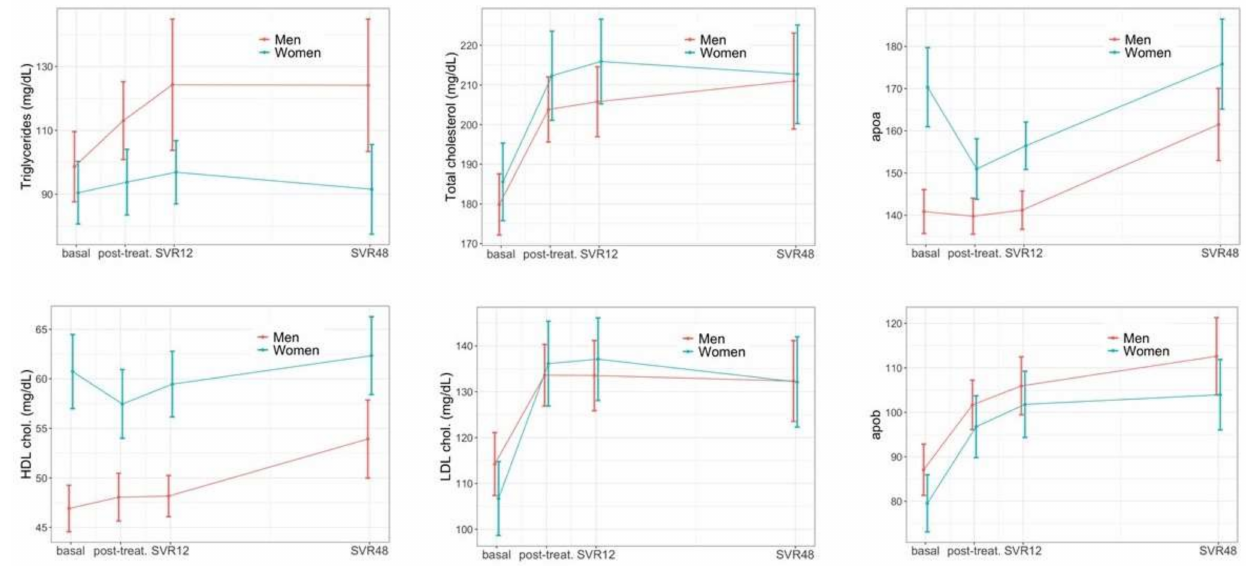
Figure 2. Lipid metabolism changes during follow-up.